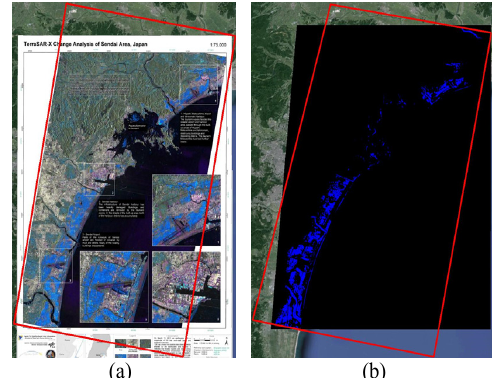
Figure 4. (a) The flood areas along the coasts are marked by blue in the thematic map. (b) The detected flood areas (blue) by using morphological approaches in this study. Both red squares indicate the range of the study area as shown in Figure 1.